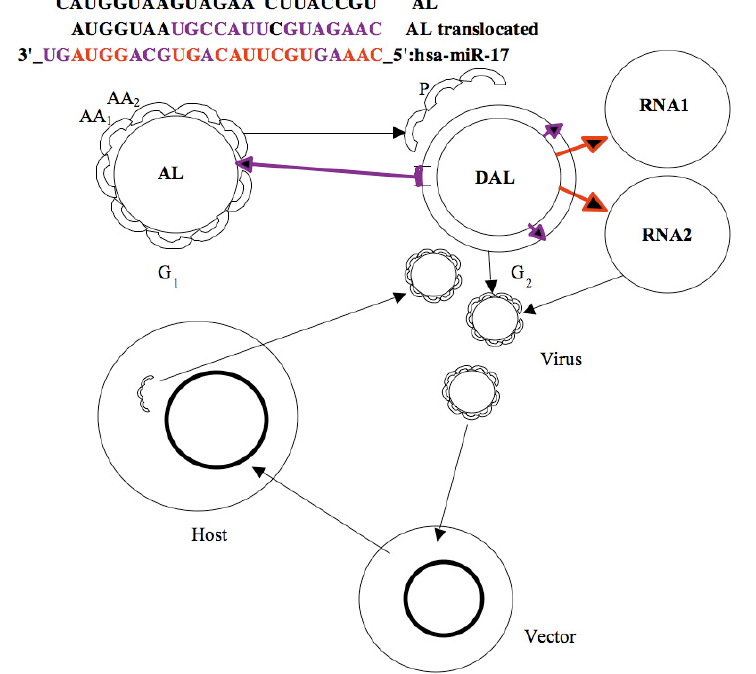
Figure 8. Evolutionary operators: Mutation/translocation/inversion/insertion (violet) and replication (red) on miR 17 (top); bi-directional exchange between AL RNA and its DNA version DAL as peptides P and RNA building machinery, and present host/vector/virus co-evolution process